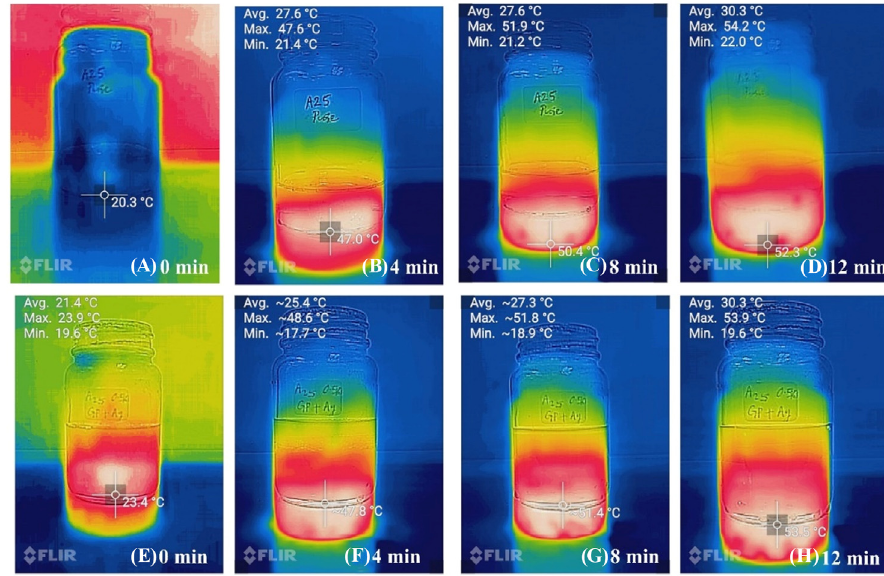
Figure 10. ( A – D ) IR images of pure A25, ( E , F ) IR image of HNePCM.